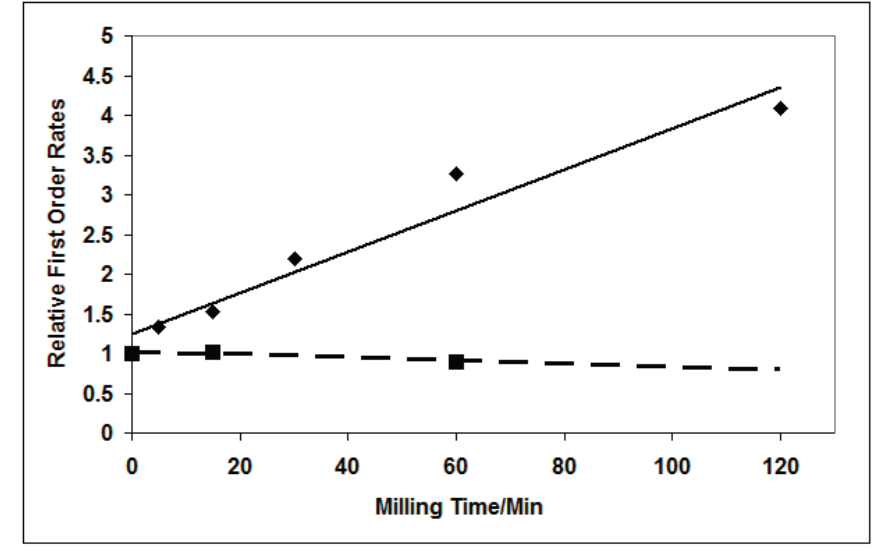
Figure 16. Effect of milling time on the DCA oxidation rate by a high area rutile ♦ and by P25 ■ . Reprinted from J. Photochem. Photobiol. A 2010 , 216 , 268–274 [40] with